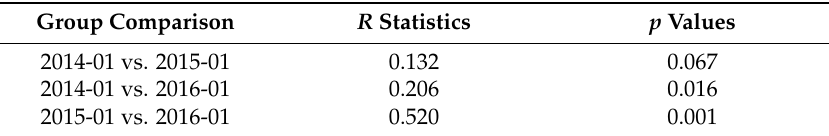
Table 1. Analysis of similarity (ANOSIM) comparisons of phytoplankton communities among groups of different years.